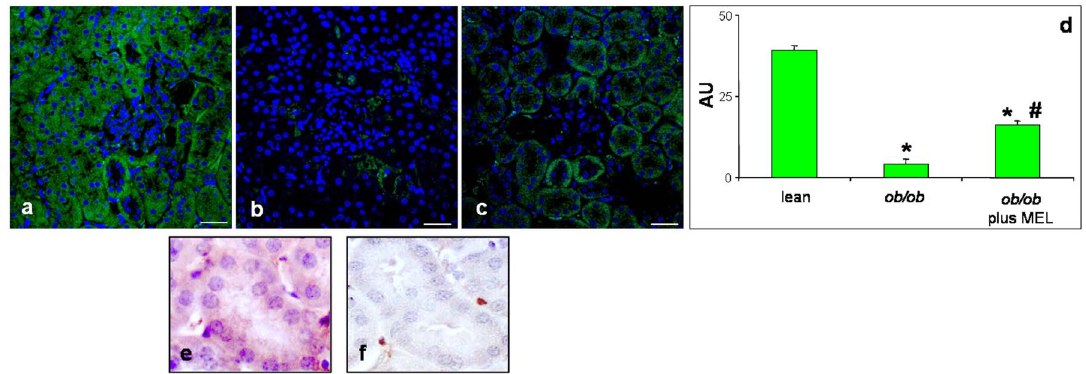
Figure 3. Mitofusin 2 immunofluorescence assay. Photomicrographs showing kidney mitofusin 2 immunostaining of lean (a, e), ob/ob (b, f) and ob/ob treated with melatonin (c) mice and relative quantitative analyses of immunopositivity (d). Bar equals 20 m m. * p , 0.05 vs lean. Nuclei were stained with 4,6 diamidino-2-phenilindole. Photomicrographs of mitofusin 2 staining showing a cortical proximal tubule immunopositive (e) and an other one immunonegative (f).